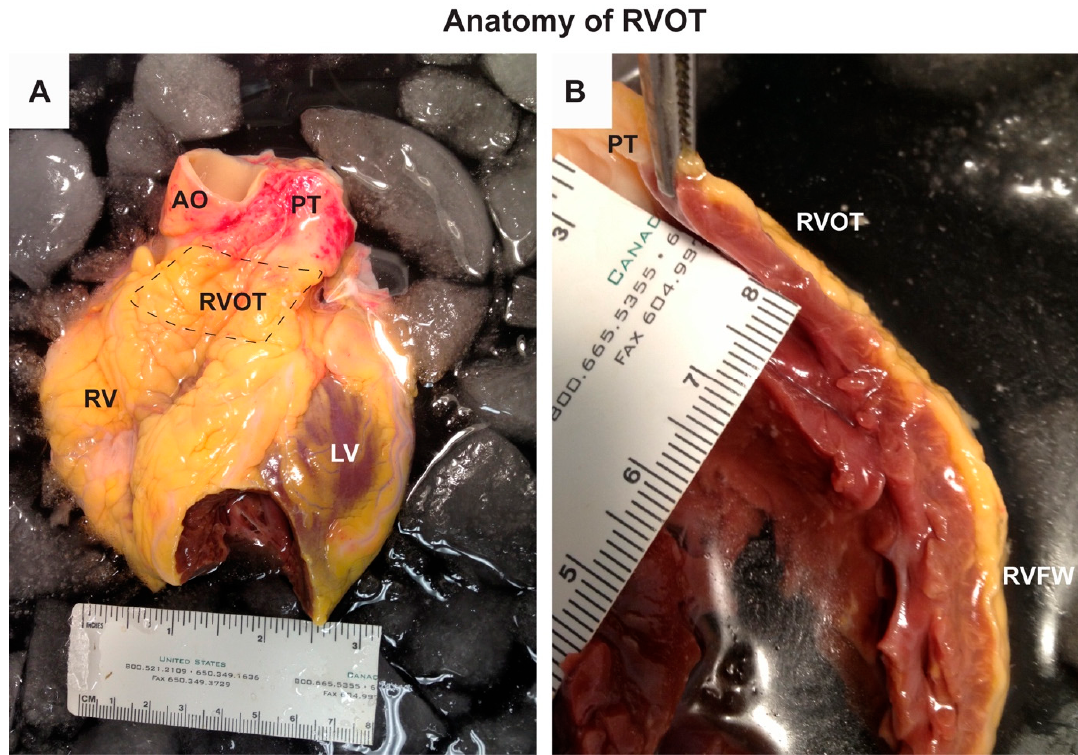
Figure 1. Anatomy of the right ventricular outflow tract (RVOT). The photographs are from a human heart of a male in his mid-fifties and taken by BJB. Theheart was provided by Mid-America Transplant Services (St. Louis, MO, USA), as described previously [34], and its use was approved by the Washington University School of Medicine Ethics Committee [Institutional Review Board (IRB)]. Panel A shows the anterior side of the heart with RVOT indicated by the dashed box. Panel B is a photograph of a cross-section of the right ventricle showing the RVOT at the top. Note the absence of the trabecles at the lumen of the RVOT. RV, right ventricle; RVFW, right ventricular free wall; LV, left ventricle; AO, aorta; PT, pulmonary